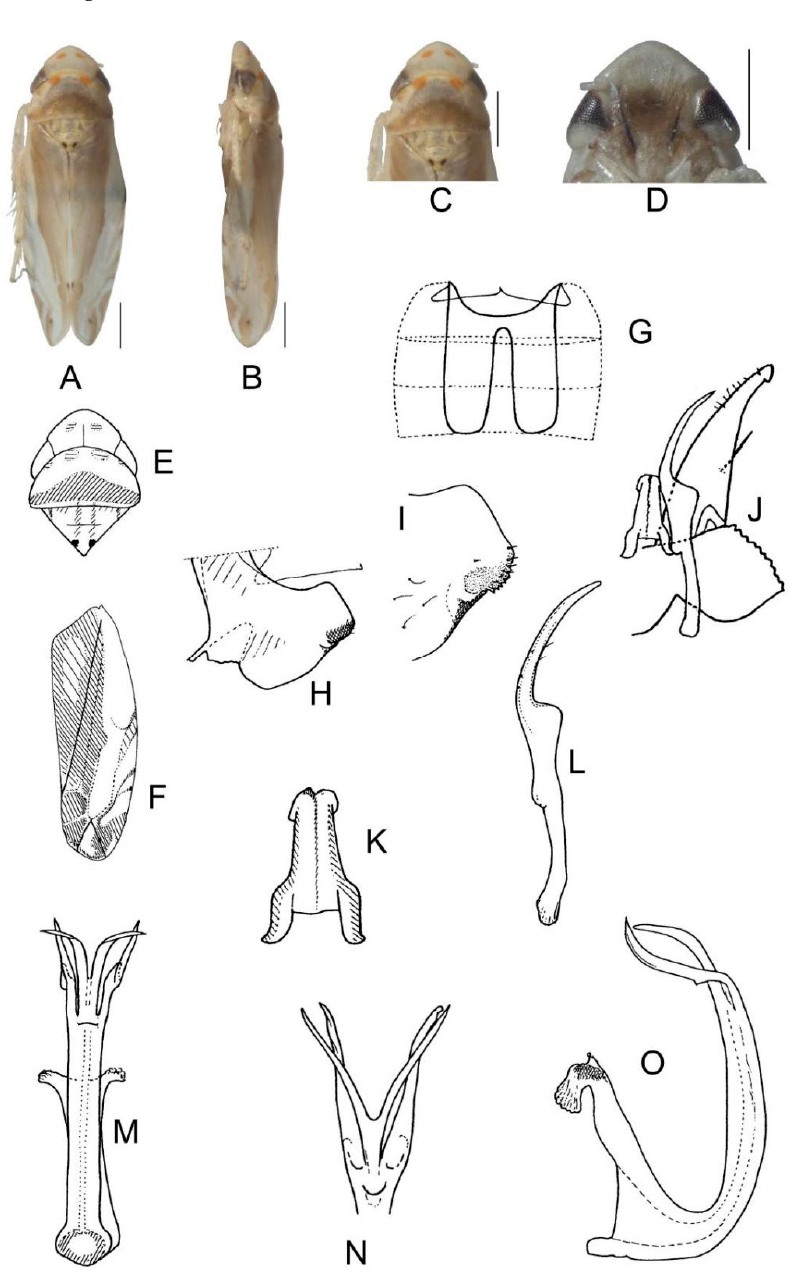
Figure 25. Eurhadina ( Singhardina ) prima rec. nov. ( E – O : Dworakowska, 2002 [3]): ( A ) habitus, dorsal view; ( B ) habitus, lateral view; ( C ) head and thorax, dorsal view; ( D ) face; ( E ) head and thorax, dorsal view; ( F ) forewing; ( G ) abdominal apodemes, dorsal view; ( H ) pygofer side, lateral view; ( I ) hind part of pygofer, lateral view; ( J ) subgenital plate, connective, paramere and sternite IX, dorsal view; ( K ) connective, dorsal view; ( L ) paramere, dorsal view; ( M ) aedeagus, posterior view; ( N ) apex of aedeagal shaft, dorsal view; and ( O ) aedeagus, lateral view. Scale bars: 0.5 mm. Eurhadina ( Singhardina ) prima Dworakowska, 2002: 81, Figures 248–258 [3]. Material examined.